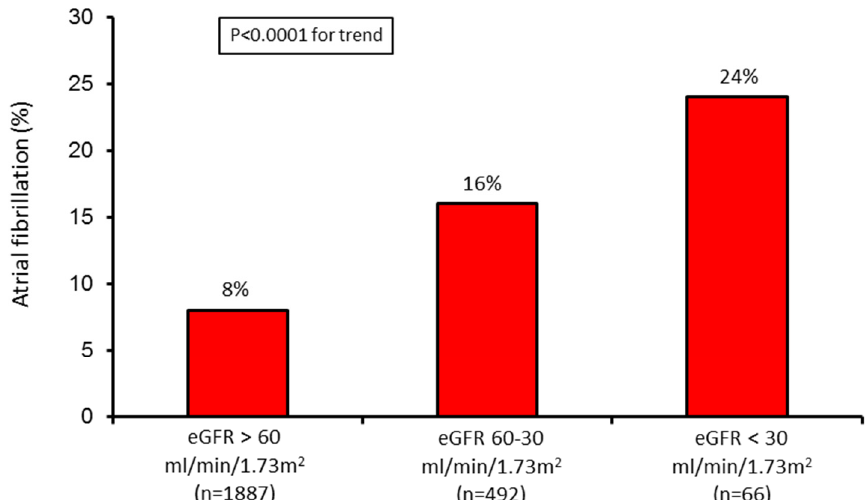
Figure 1. Incidence of atrial fibrillation (AF) in the three study groups. eGFR = estimated glomerular filtration rate. Table 3. Adjusted odds ratio (OR) and 95% confidence intervals (CI) for independent predictors of atrial fibrillation found at stepwise analysis in the overall study population.